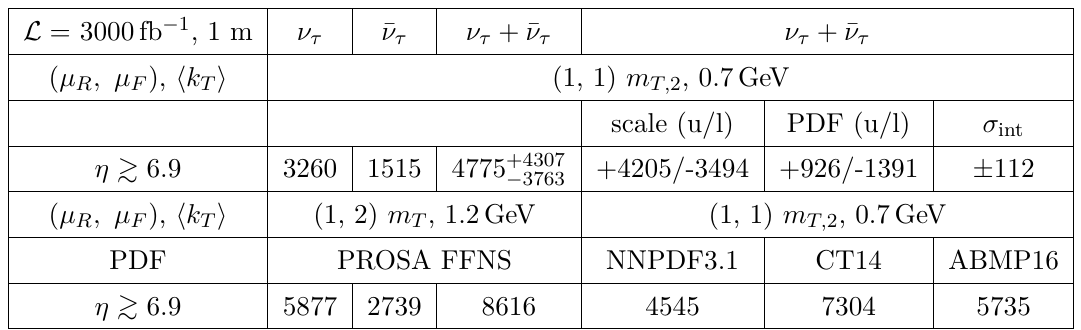
Table 4. The number of charged-current interaction events induced in 1 meter length of tungsten by tau neutrinos and antineutrinos from D ± integrated luminosity L = 3000 fb − 1 and η ν & 6 . 9